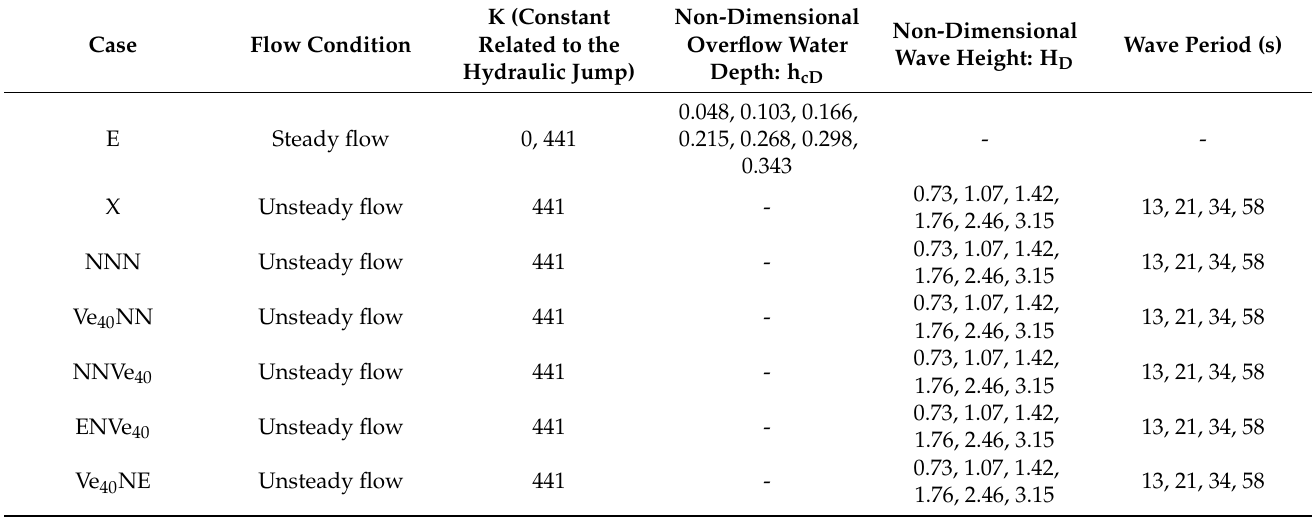
Table 1. List of the models and hydraulic conditions simulated in this study.